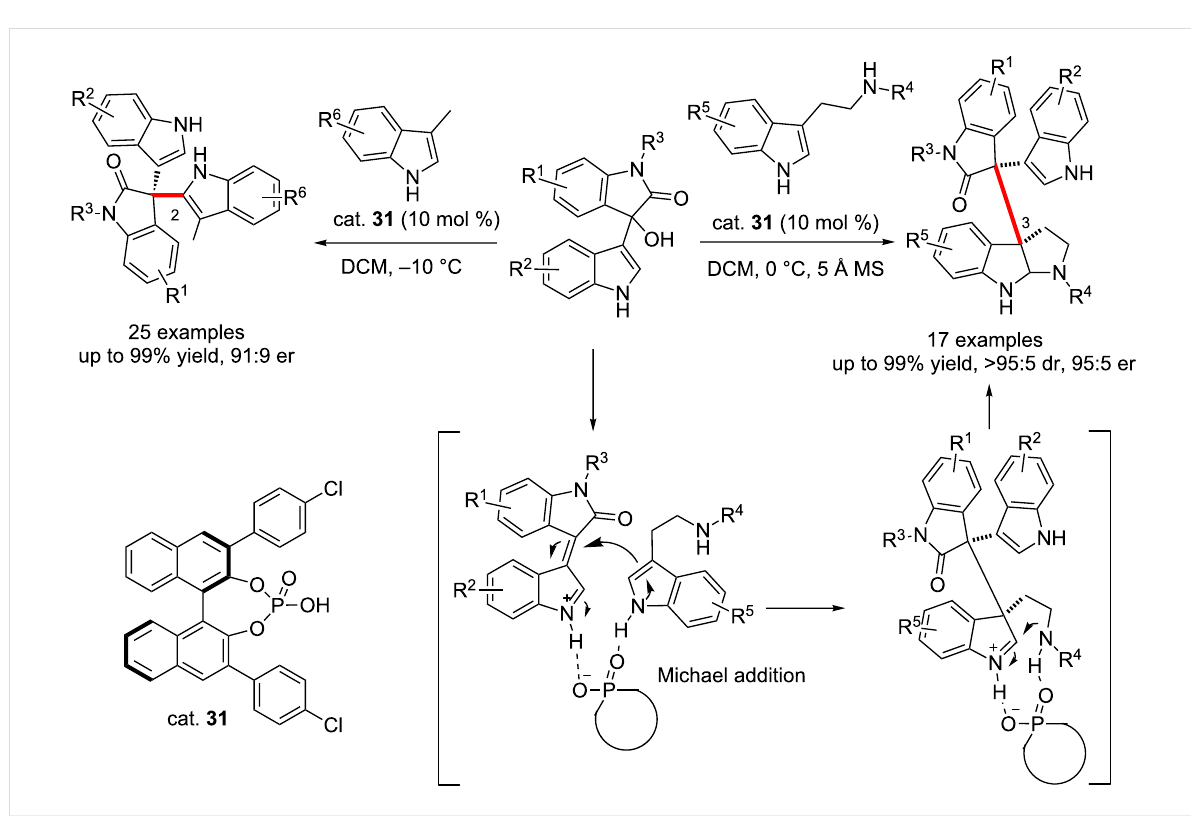
Scheme 49: CPA-catalyzed dearomatization and arylation of 3-indolyl-3-hydroxyoxindoles with tryptamines and 3-methyloxindoles,